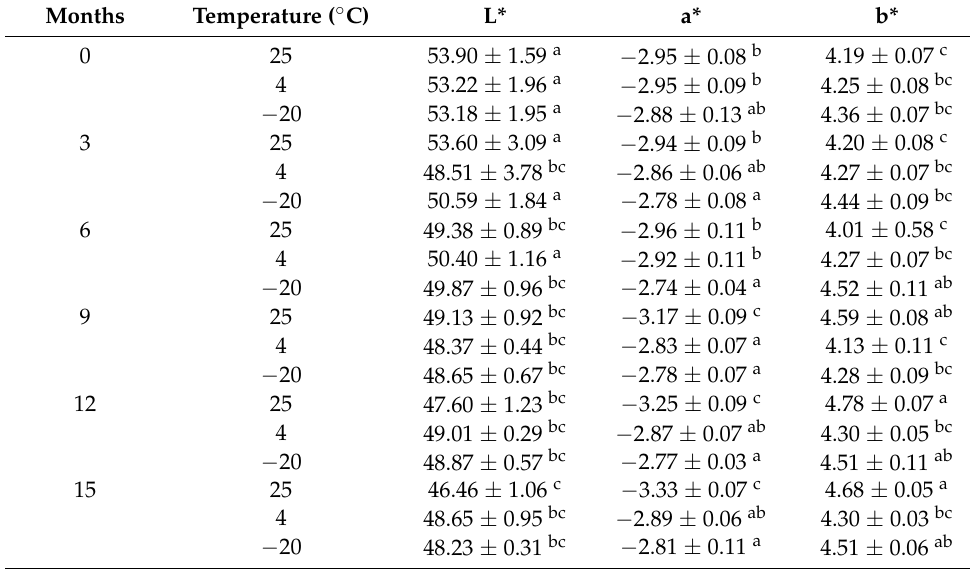
Table 2. Color characteristics of wheat noodles fortified with isomaltodextrin during different storage